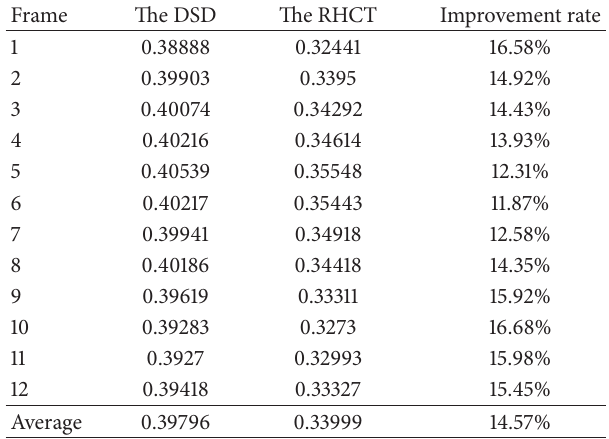
Table 5: Perceived quality comparison for simplified horse anima- tion models using